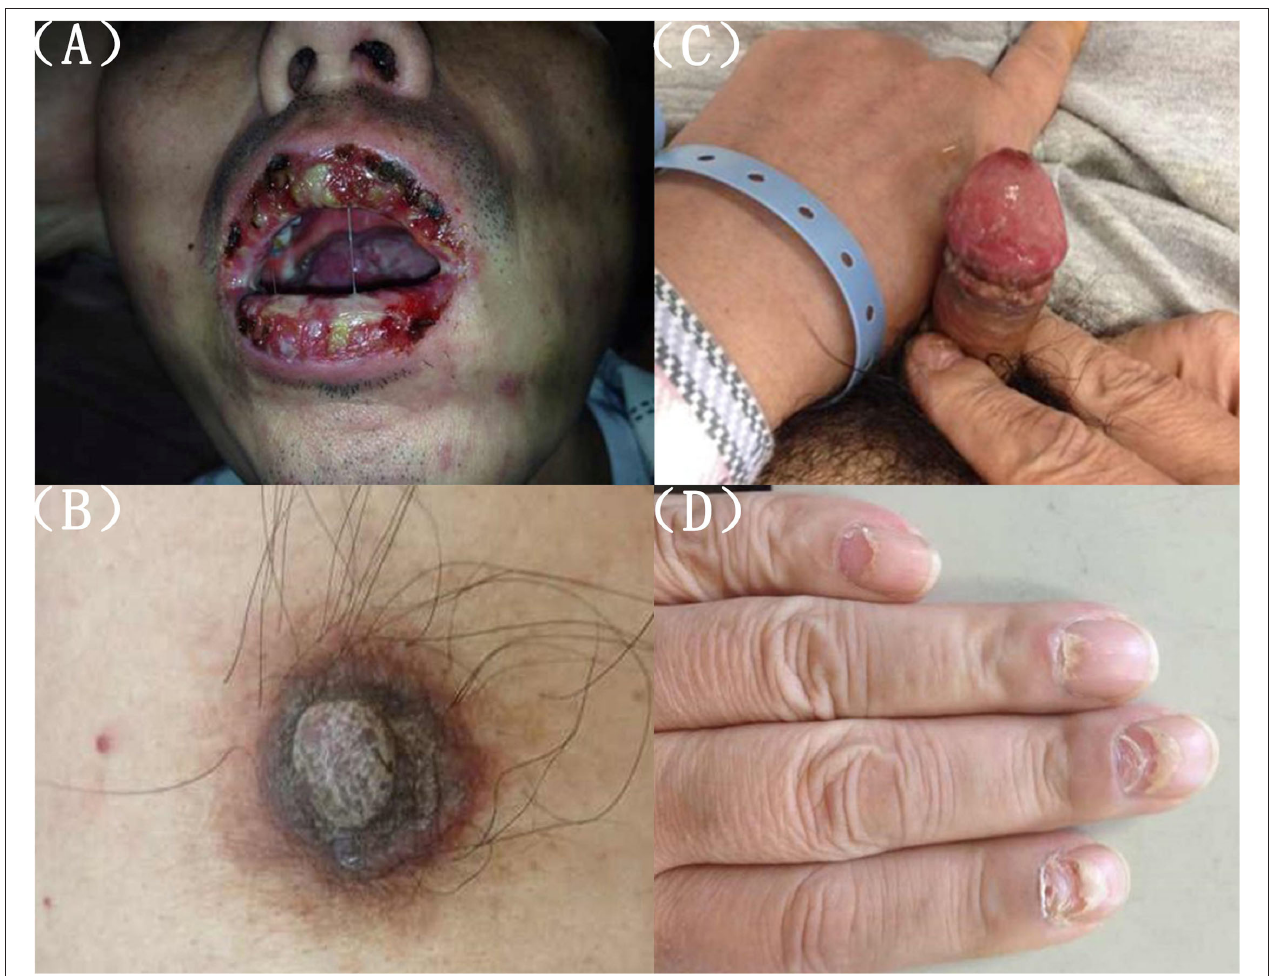
FIGURE 1 | (A) Peri-oral lesions. Palatal and buccal mucosal ulcers and maculopapular lesions, lip crusts. (B–D) Scales on nipple, ulceration of genital, and nail lesions on fingers and